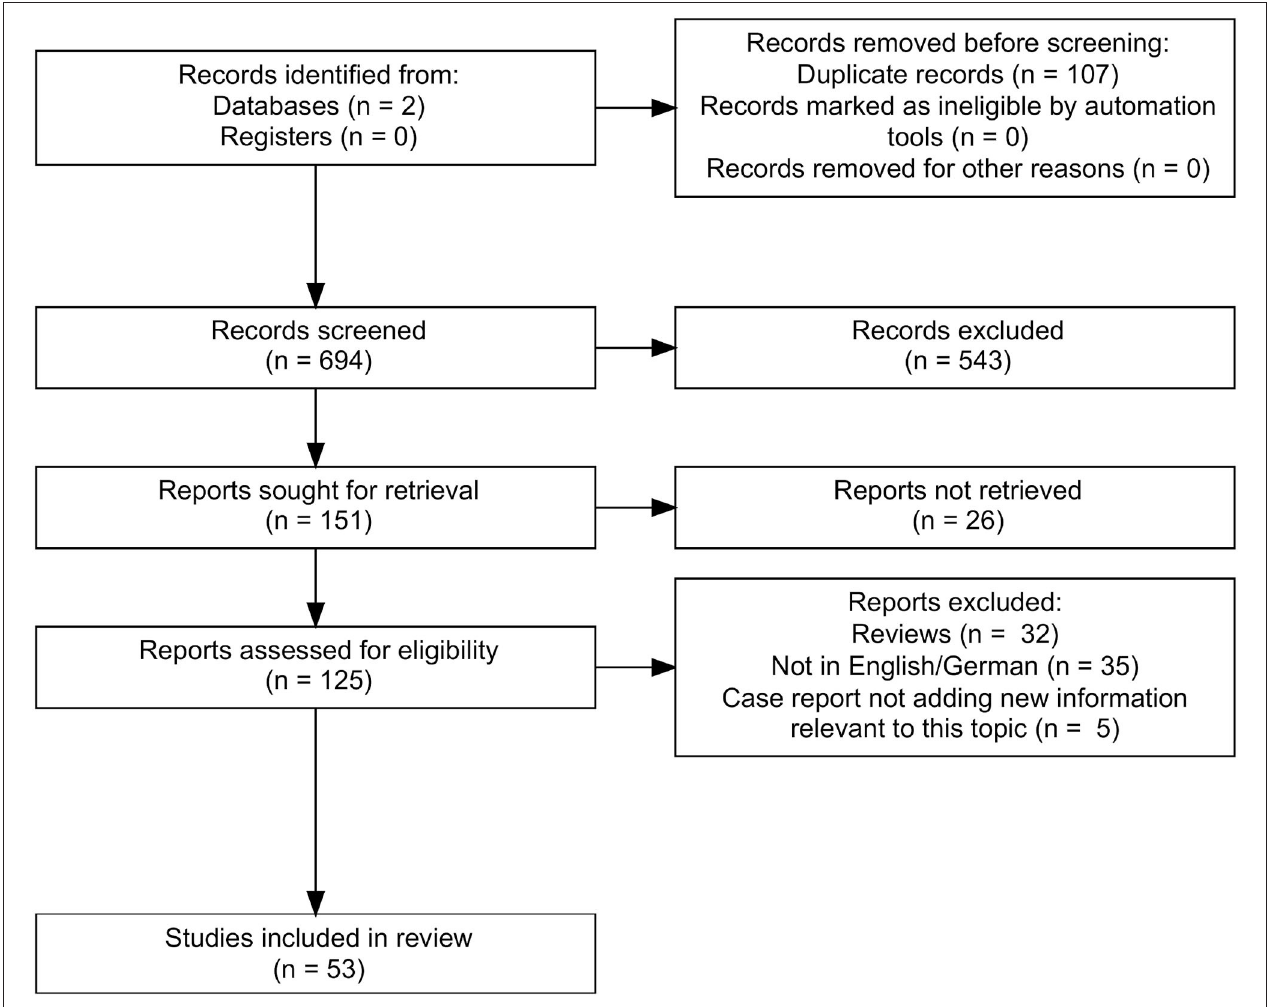
FIGURE 1 | Flow chart reporting the search strategy according to PRISMA (10). We searched PubMed and Google Scholar and found 801 papers. After excluding doubles, there were 694 results left, of which 543 were not on the topic of this review. We finally retrieved 125 publications, of which 32 were reviews, 35 were not in English or German, and 5 case reports did not add new information to our topic. Thus, 53 articles were included in this systematic